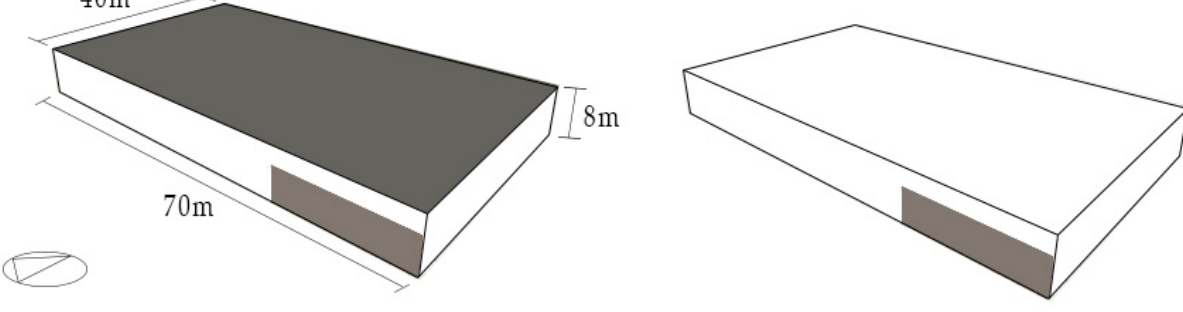
Figure 3. Isometric view of the building model. Black finish surface for the winter season and white finish surface for summer seasons. Table 1. Summary of areas per façade and roof.